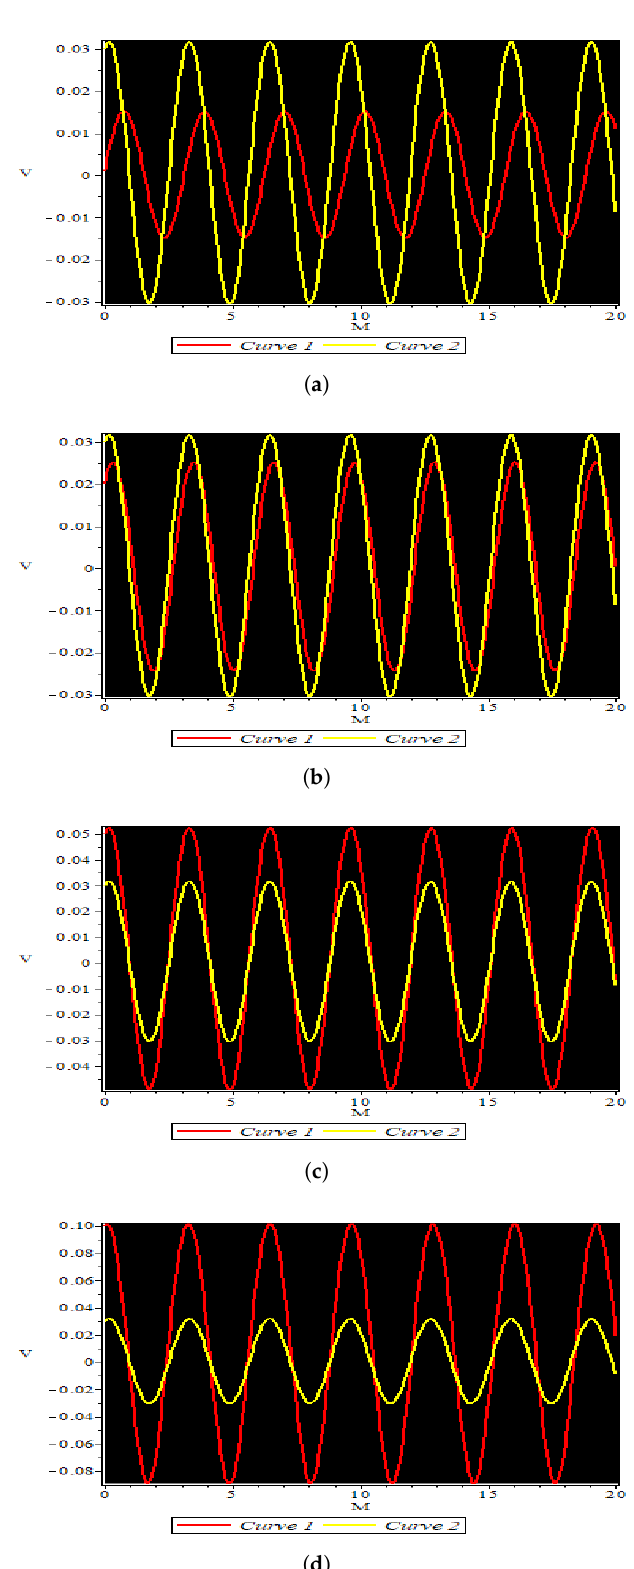
Figure 7. Sensitivity assessment at different initial conditions. ( a ) Sensitive visualization for curve 1 at (0.001,0.03) and curve 2 at (0.03,0.02); ( b ) sensitive visualization for curve 1 at (0.02,0.03) and curve 2 at (0.03,0.02); ( c ) sensitive visualization for curve 1 at (0.05,0.03) and curve 2 at (0.03,0.02); ( d ) sensitive visualization for curve 1 at (0.1,0.03) and curve 2 at